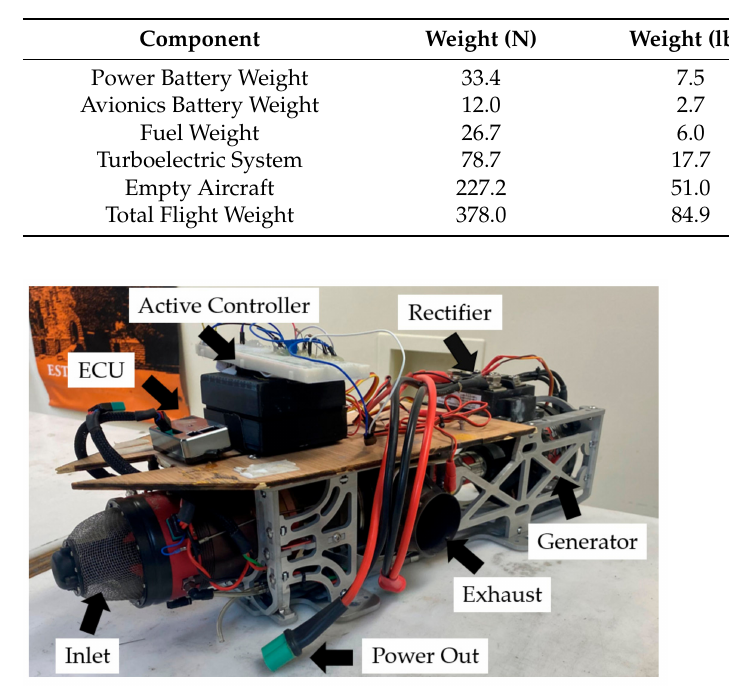
Figure 4. Assembled Turboelectric